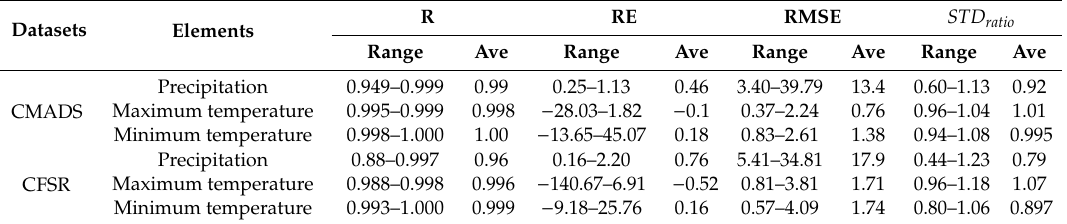
Table 5. Average statistical indicator values for comparing CMADS and CFSR with observed